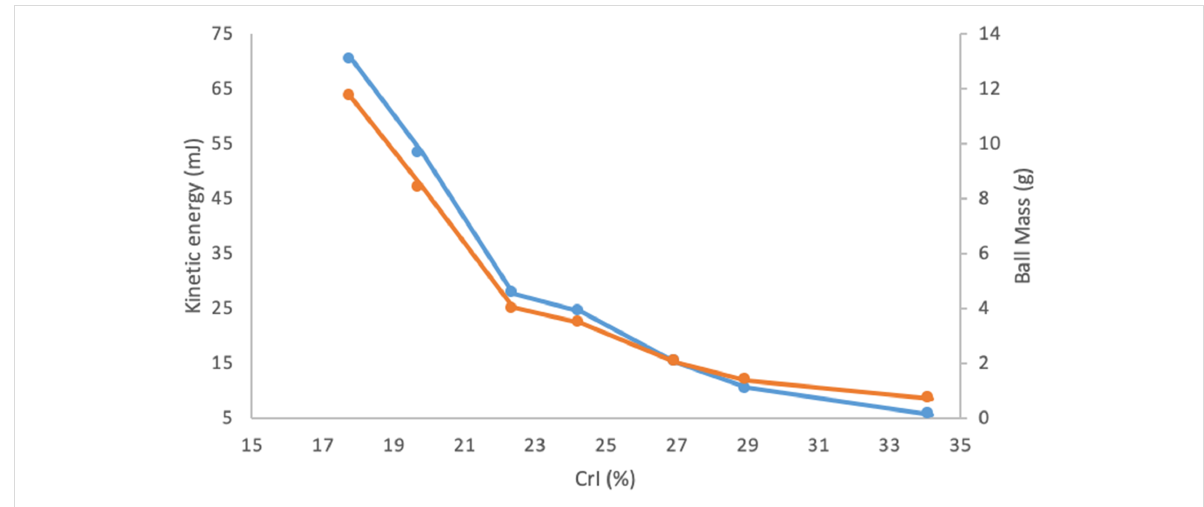
Figure 5: Correlation between the ball mass (orange line) or kinetic energy (blue line) with the crystallinity of chitin after milling in SS jar fitted with 1 SS ball. Experimental conditions: 200 mg of chitin, milling time: 30 min, frequency 29.5 Hz.